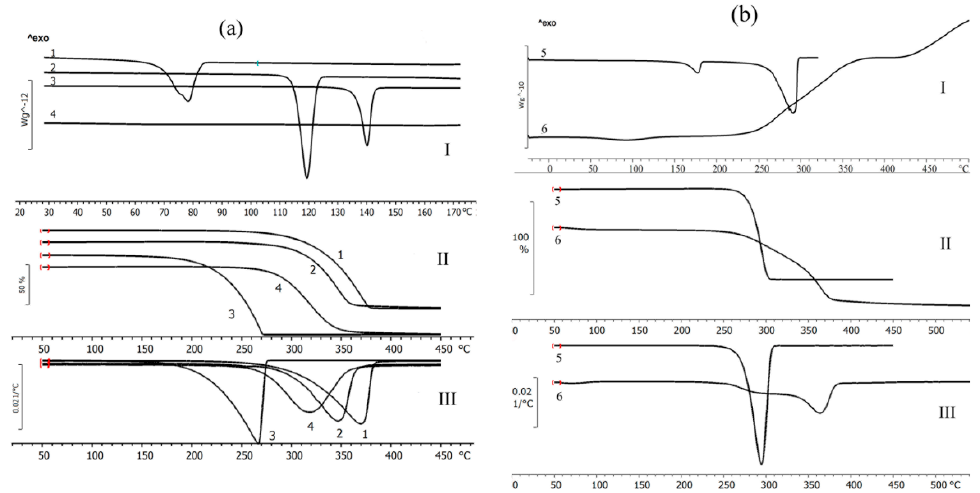
Figure 3. Results of thermal analysis of fungicides ( a ) and materials of the matrix (polymer and wood flour) ( b ): I—DSC curves; II—TGA curves; III—weight loss of the samples under heating in